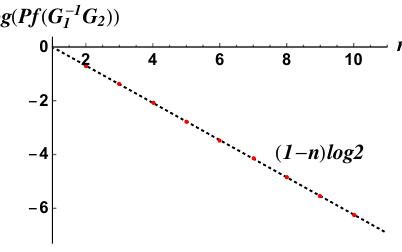
Figure 8 . The replica diagonal solution G 2 (a) and replica non-diagonal solution G 1 (b) of Schwinger-Dyson equation for the third R(cid:19)enyi entropy. (b) shows clearly the nonvanishing cor- relation is sourced by the twist operator. We choose the parameter J T = 24, V = J = 0 : 2, q = 4. The number of discretization is M = 400.